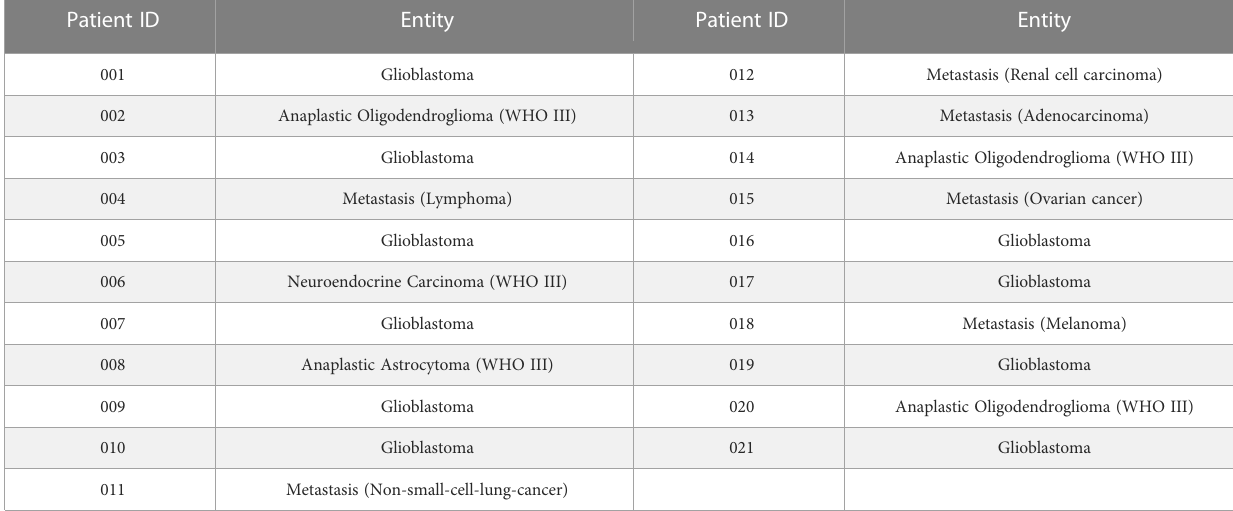
TABLE 1 List of tumor entities for 21 brain tumor